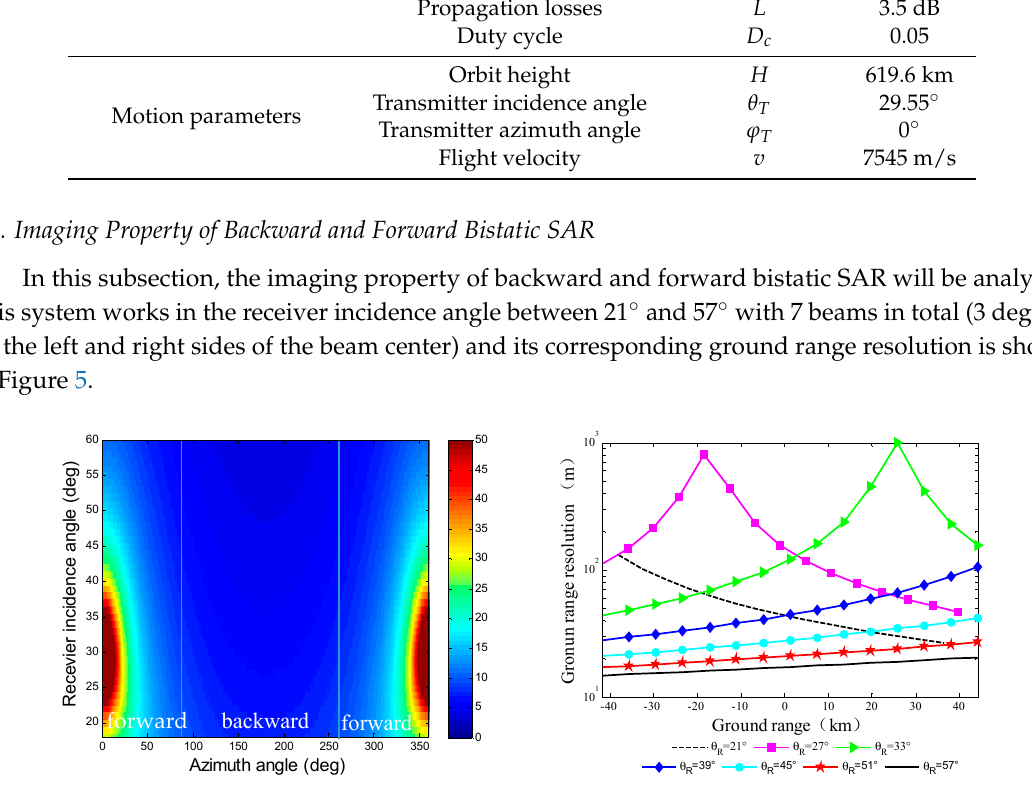
Table 1. Key simulation parameters.